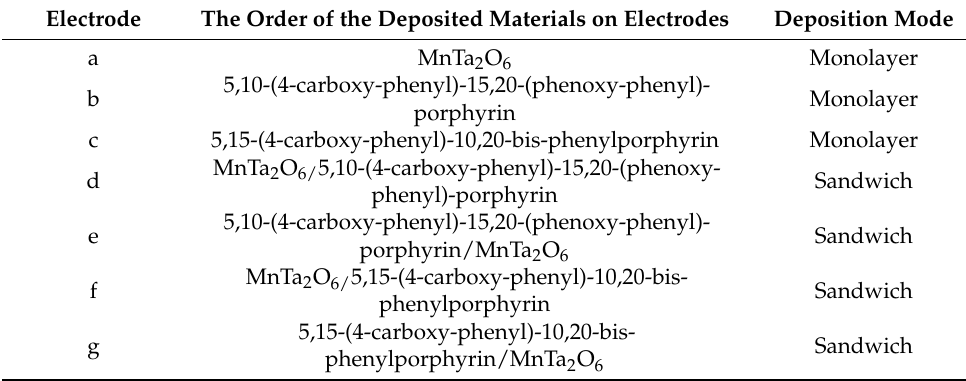
Table 1. Drop-casting thin film